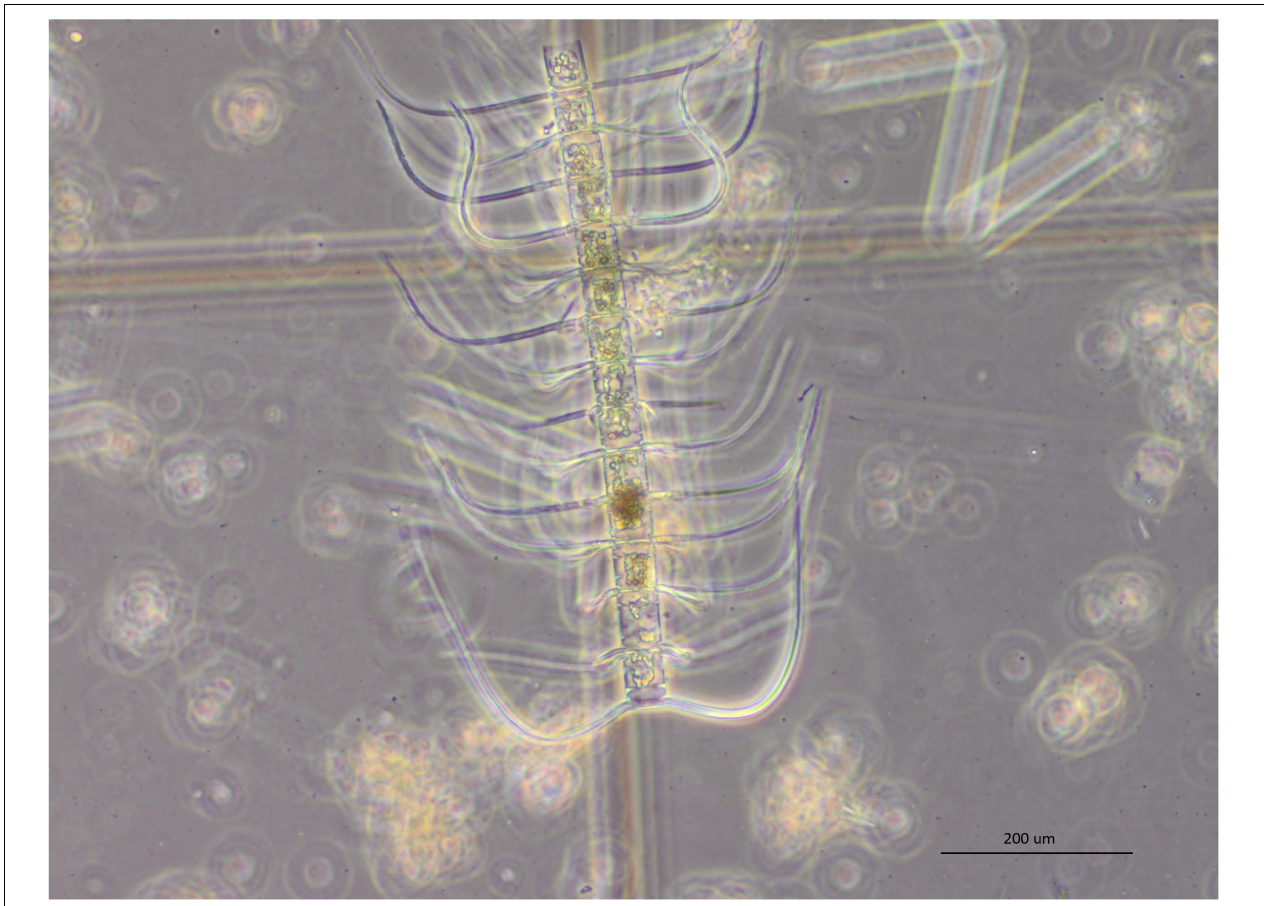
FIGURE 9 | A chain of 14 Chaetoceros coarctatus cells detected in water samples along the metropolitan Adelaide Coastline in April 2013 (20 × mag.). A single cell of C. coarctatus typically has an apical axis of 25–45 µ m and a transapical axis of 13–20 µ m and armed with conspicuous spines. They can form long and robust chains typically of 12–16 cells long (Hasle and Syvertsen, 1997; Lee and Lee,